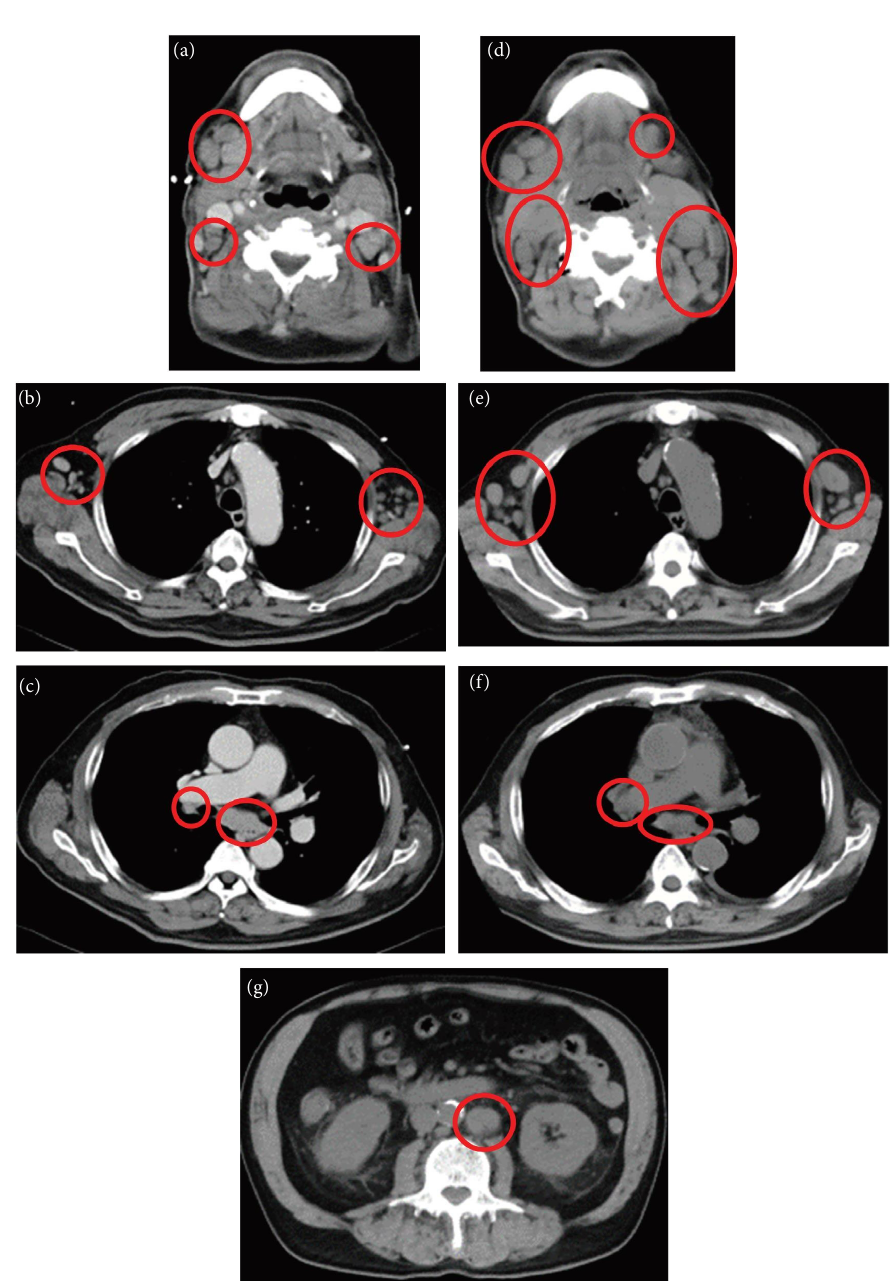
Figure 1: Computed tomography revealed multiple lymph node swellings. Computed tomography scans at the frst visit (a, b, and c) and four months later (d, e, f, and g), shows the cervical lymph nodes (a, d), axillary lymph nodes (b, e), mediastinal lymph nodes (c, f), and para- aortic lymph node